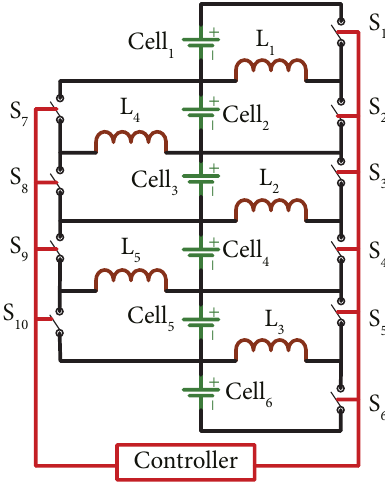
Figure 6: Buck-boost converter-based